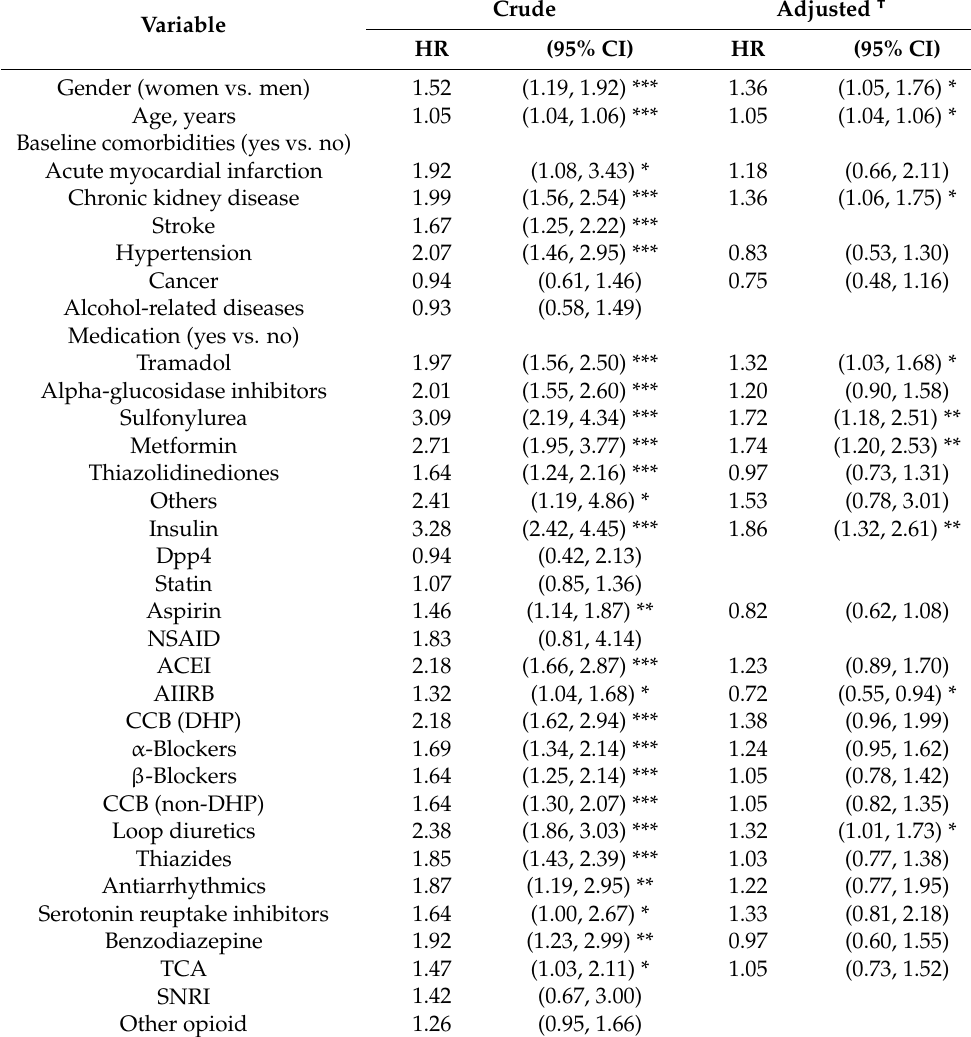
Table 3. Cox model with hazard ratios and 95% confidence intervals of hypoglycemia associated with tramadol use and covariates among diabetes patients without cancer.